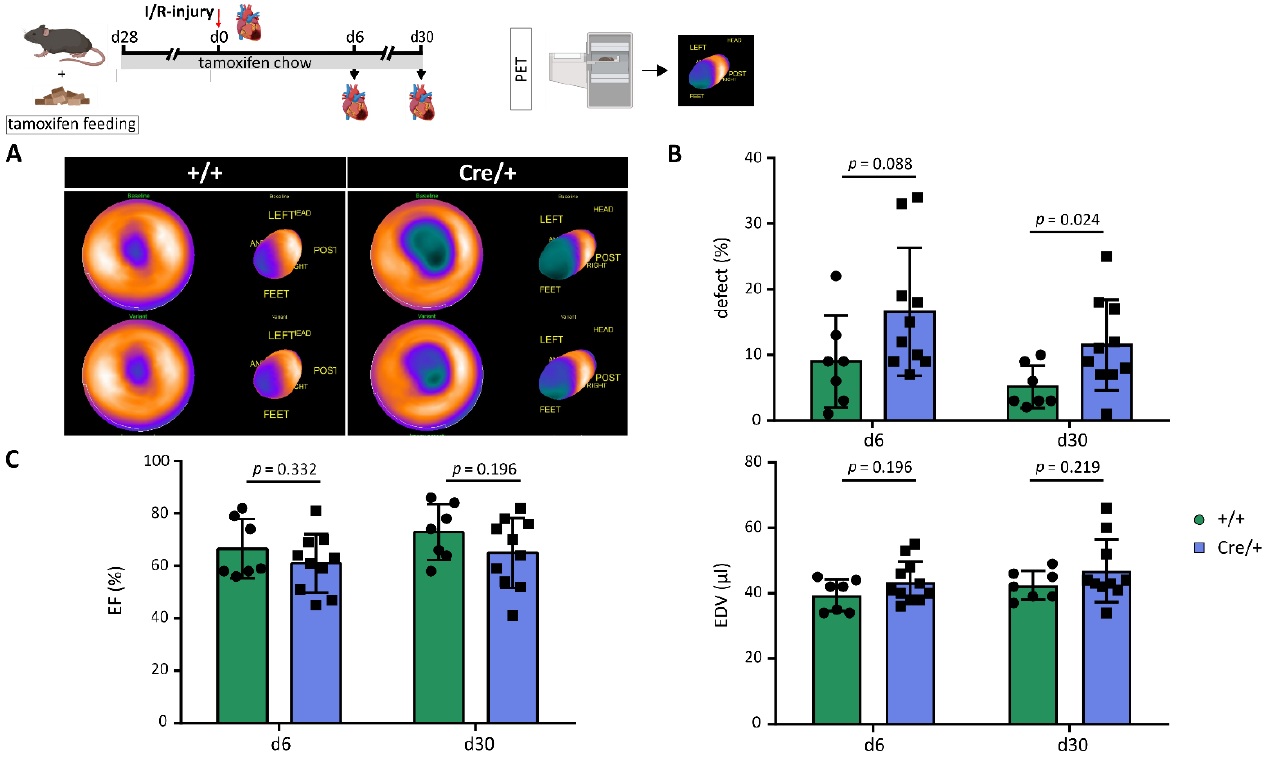
Figure 3. Reduction of myeloid Rxrα expression increases infarct size after I/R injury. ( A ) PET imaging to assess the cardiac defect on d6 and d30 after MI; ( B ) comparison of cardiac defect on d6 and d30 after MI between Cx3cr1ΔRxrα and control mice; ( C ) assessment of functional parameters (EDV and EF) on d6 and d30 after MI in Cx3cr1ΔRxrα and control mice. Flowchart was created with BioRender.com. control (+/+): control mice [littermates with a floxed Rxrα allele but without Cre expression]; Cx3cr1ΔRxrα (Cre/+): mice with a floxed Rxrα allele and Cre expression; EDV: end-diastolic volume; EF: ejection fraction; I/R injury: Ischemia/Reperfusion injury; PET: positron emission tomography; Rxr: Retinoid X receptor.